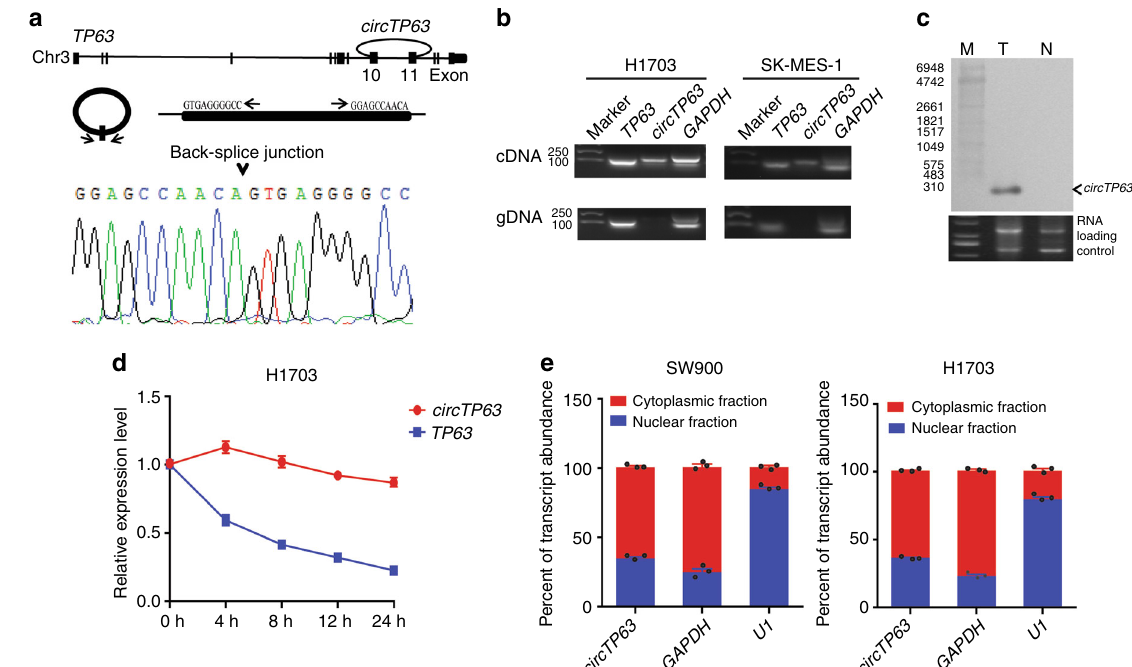
Fig. 2 Characterization of circTP63 in LUSC cells. a Genomic loci of circTP63 gene. circTP63 is produced at the TP63 gene (NM_003722.4) locus containing exons 10 – 11. The back-splice junction of circTP63 was identi fi ed by Sanger sequencing. b PCR analysis for circTP63 and its linear isoform TP63 in cDNA and genomic DNA (gDNA). c Northern blot analysis showed the size and abundance of circTP63 in one paired sample of LUSC tumorous tissue and corresponding adjacent nontumorous tissues. M: marker. d qRT-PCR for the abundance of circTP63 and TP63 in H1703 cells treated with Actinomycin D at the indicated time point. e Levels of circTP63 in the nuclear and cytoplasmic fractions of SW900 and H1703 cells. The error bars ( d , e ) represent s.d. ( n =